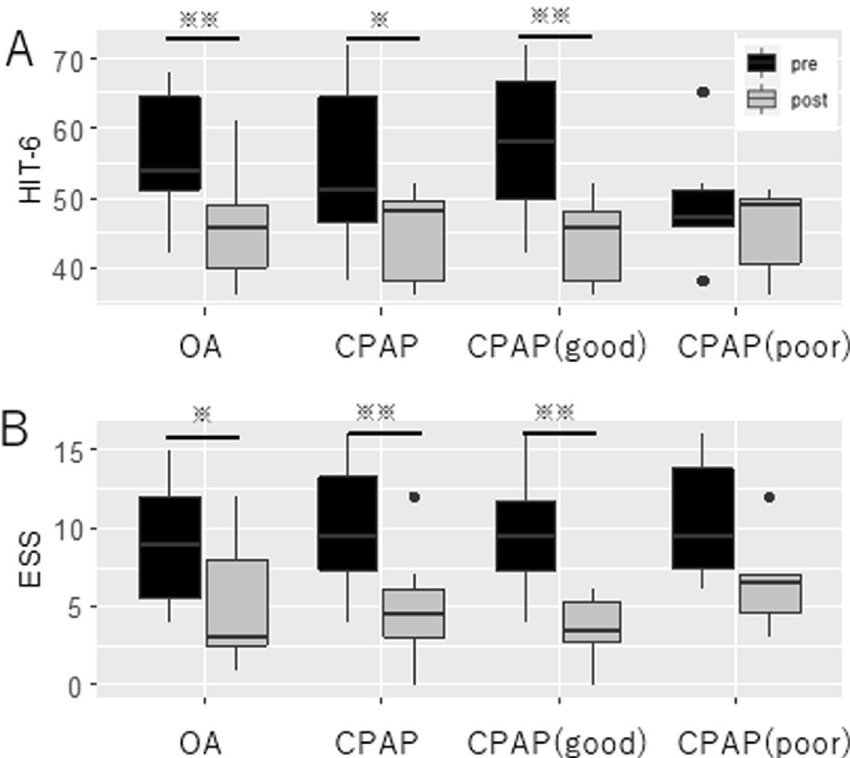
Fig. 4 HIT-6 (A) and ESS (B) scores before and after treatment. CPAP (good) shows results in the good-adherence subgroup. CPAP (poor) shows results in poor-adherence subgroup. * p < 0.05 and ** p < 0.01 based on the Wilcoxon signed-rank test. The effect size of the results with p < 0.01 was at least 0.55, indicating large effect